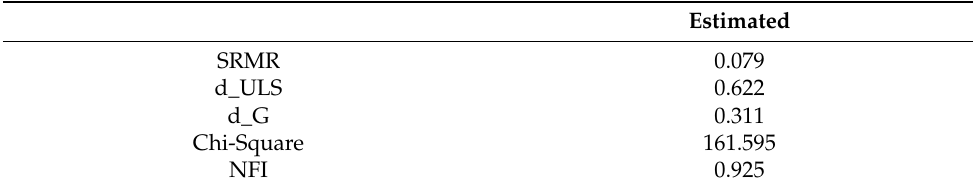
Table 12. Model fit.